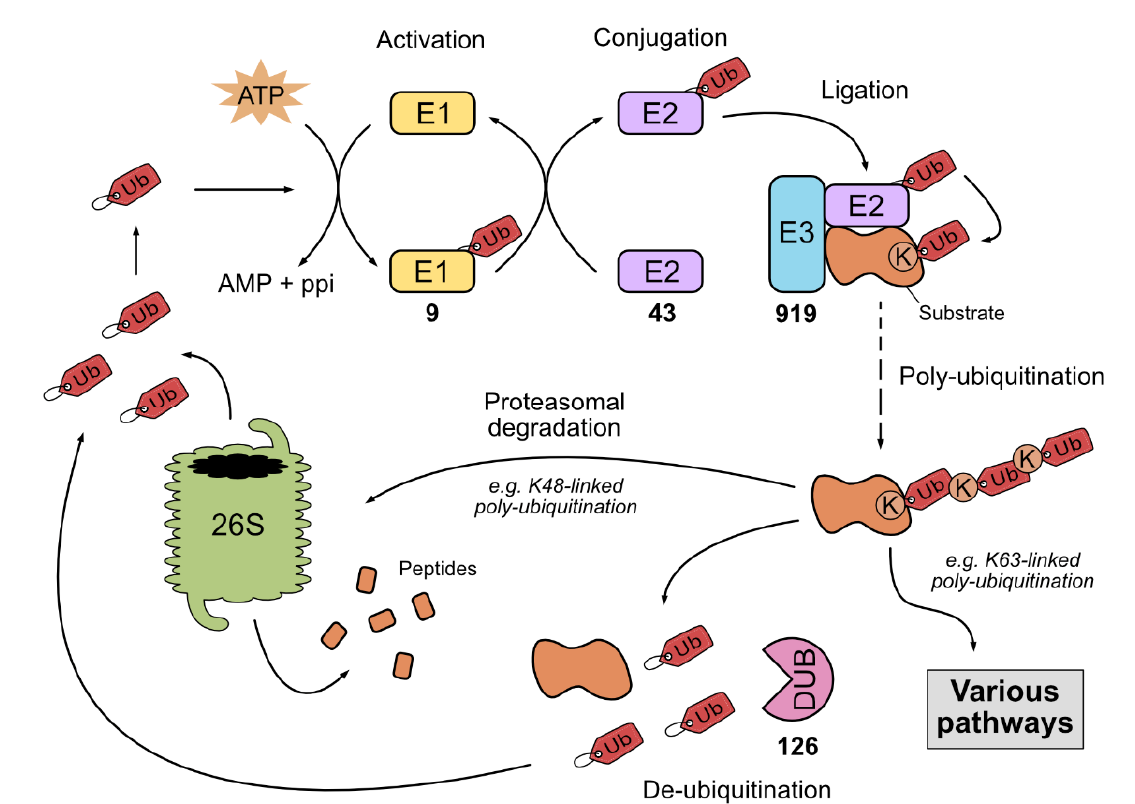
Figure 1. Ubiquitin-proteasome system. Ubiquitin (Ub) is first attached to the ubiquitin-activating enzyme E1 in an ATP-dependent way. Ubiquitin is then transferred to the ubiquitin-conjugating enzyme, E2. An isopeptide bound is finally catalyzed between the ubiquitin and a lysine (K) residue on a protein substrate by the ubiquitin ligase, E3. The ubiquitinated protein can subsequently be poly-ubiquitinated through K residues within ubiquitin itself. Depending on the linkage type, the protein will then undergo different fates in various cellular pathways. De-ubiquitinase enzymes (DUB) can recognize and hydrolyze isopeptide bonds formed between ubiquitin and protein substrate and between ubiquitin moieties, leading to the recycling of ubiquitin. K48-linked poly-ubiquitination leads to targeted protein degradation by the 26S proteasome, releasing free ubiquitins, which are reincorporated in the loop or used in other pathways. For each category of enzymes (E1, E2, E3 and DUB), the number of proteins in humans are indicated (source: IUUCD 2.0 database).